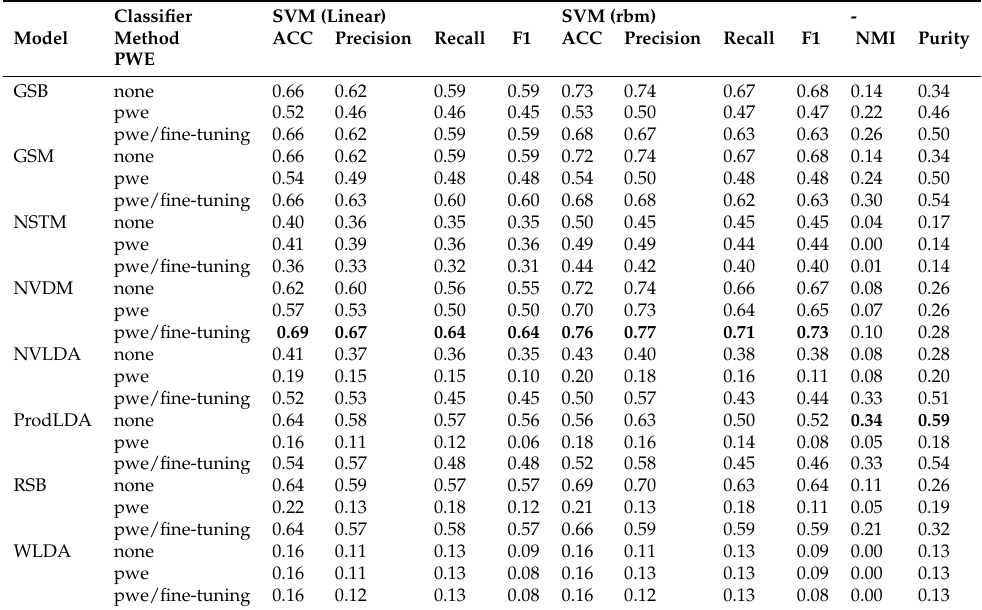
Table 28. Classification and Clustering performance on M10.